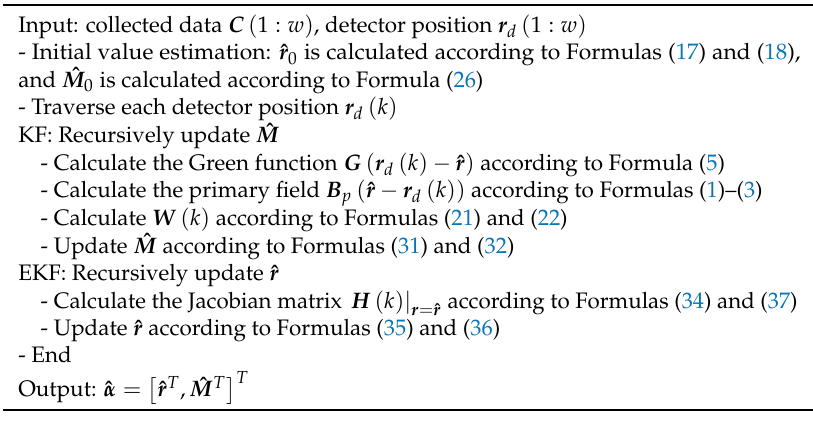
Table 1. Initial value estimation method for the Kalman filter (KF) and the extend Kalman filter (EKF) (IVE-KF) algorithm iteration